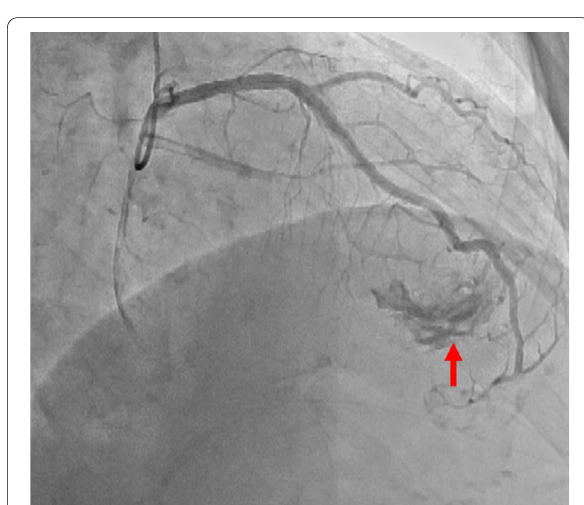
Fig.4 Coronary angiography of a shunt flow from the anterior descending branch to the ventricle